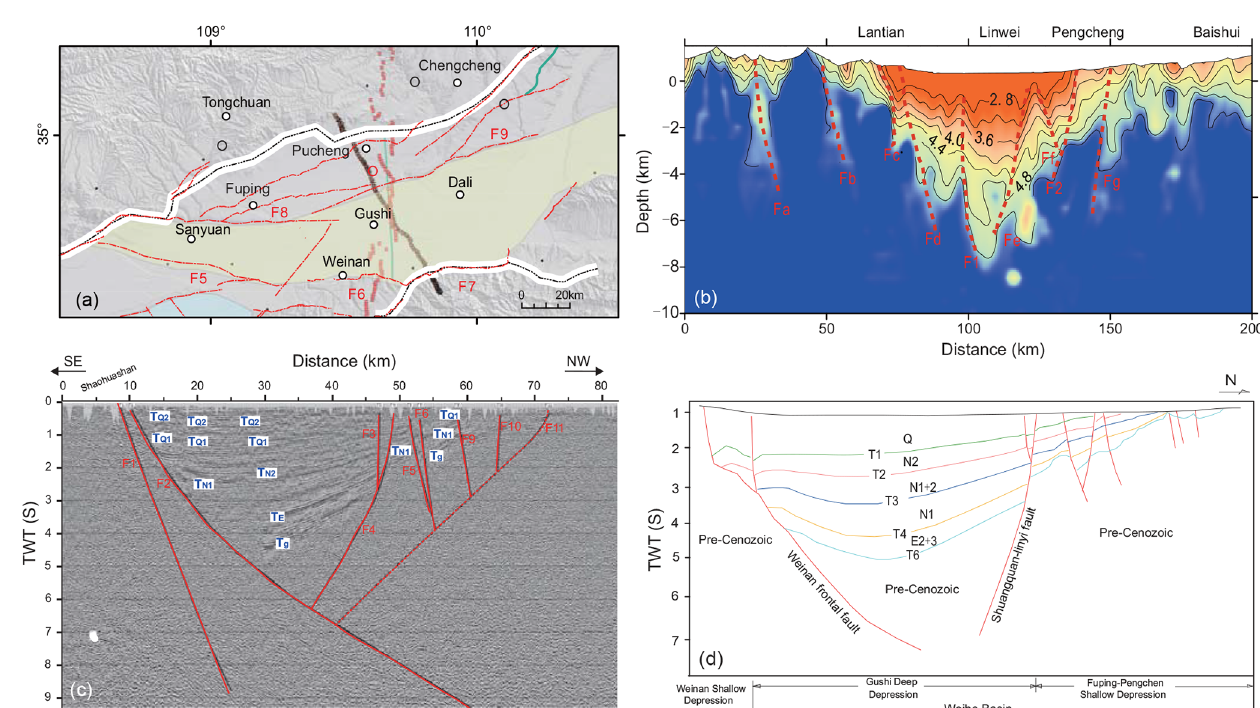
Figure 4. Geophysical survey interpretation of the eastern depression (Gushi) in the Weihe Basin. (a) Seismic survey lines in the eastern (Gushi) depression. (b) Wide-angle reflection results show that the depth of the Gushi depression can reach ∼ 7500m. (c) Deep seismic reflection profile. (d) Stratigraphical interpretation based on mid–deep seismic reflection